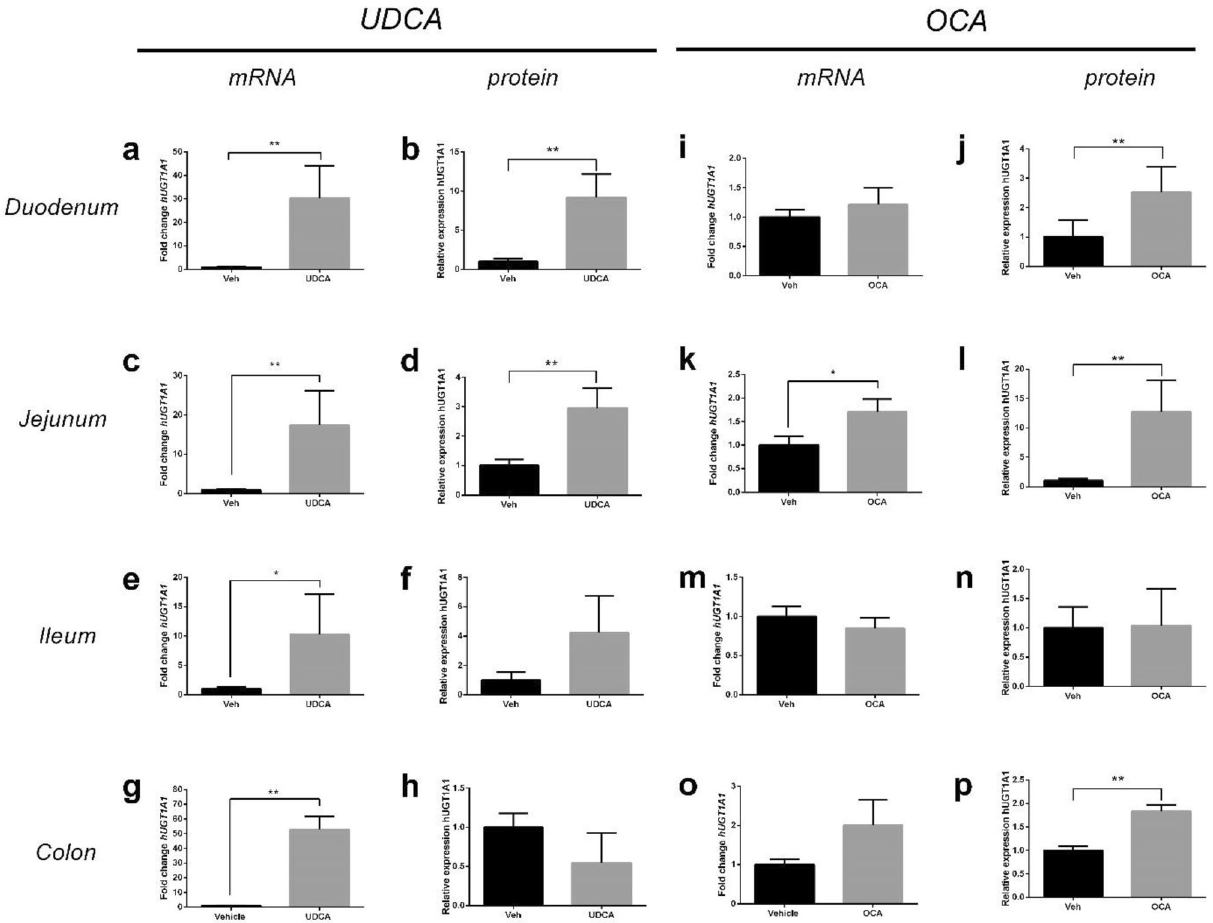
Figure 2. Effect of UDCA and OCA on intestinal hUGT1A1 mRNA and protein expression in neonatal hUGT1*1 mice. hUGT1A1 gene and protein expression after UDCA treatment in ( a , b ) duodenum, ( c , d ) jejunum, ( e , f ) ileum and ( g , h ) colon (n = 6). hUGT1A1 expression after OCA treatment in ( i , j ) duodenum, ( k , l ) jejunum, ( m , n ) ileum and ( o , p ) colon (n = neonates. This decrease in TPB was also associated with decreased brain bilirubin content (18%), although this did not reach statistical significance (Fig. S1). Effect of UDCA and OCA on hUGT1A1 expression in liver and intestine. To assess whether UDCA or OCA affected UGT1A1 expression in hUGT1*1 neonatal mice, we determined mRNA and protein levels in liver and intestine. Classically, the liver is regarded as the main organ responsible for bilirubin conjugation 24 . As expected, UGT1A1 expression was not detectable in the liver of neonatal hUGT1*1 mice 17 , and was also not induced by UDCA or OCA (data not shown). In contrast to the liver, UDCA treatment strongly increased levels of UGT1A1 mRNA in all intestinal sections (duodenum, jejunum, ileum and colon; Fig. 2a,c,e,g), whereas OCA treatment (Fig. 2i,k,m,o) only caused a 1.7-fold induction in jejunum (p < 0.05) (Fig. 2k). To assess whether the increased intestinal UGT1A1 gene expression also resulted in increased protein expression, we performed Western blot analysis. In line with its mRNA levels, UGT1A1 protein levels were undetectable in liver whereas both UDCA (Figs. 2b,d,f,h; Fig. S2) and OCA (Figs. 2j,l,n,p; Fig. S2) treatment significantly increased hUGT1A1 protein levels in duodenum (both p < 0.01) and jejunum (both p < 0.01), but not in ileum. In colon, UGT1A1 protein expression was only induced after OCA treatment (p < 0.01) (Fig. 2p). FXR activation by UDCA and OCA.